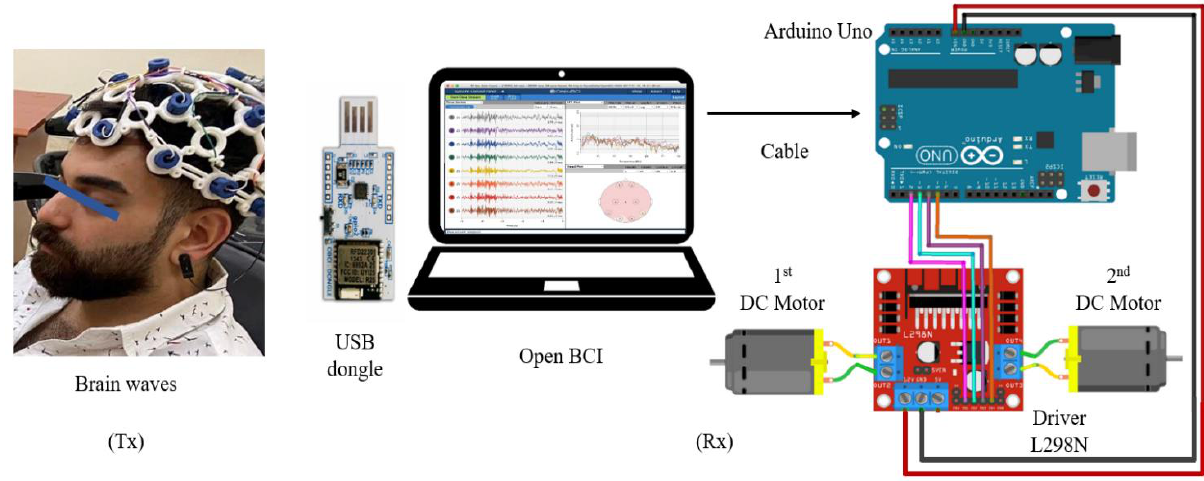
Fig. 13. The hardware circuit.